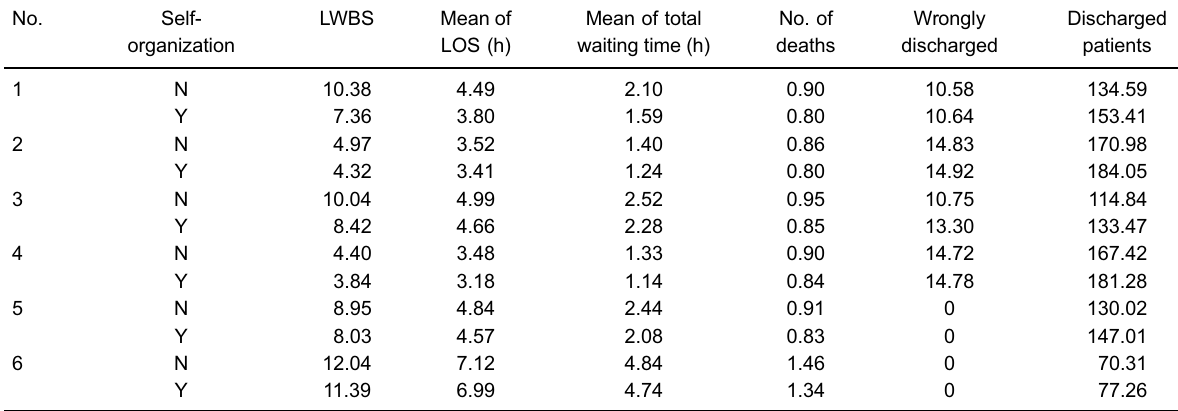
Table 3. Measured key performance indicators for each scenario, with (Y) and without (N) group decision-making.